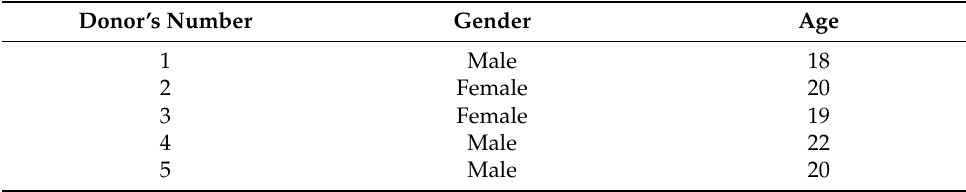
Table 1. Donors’ gender and age.